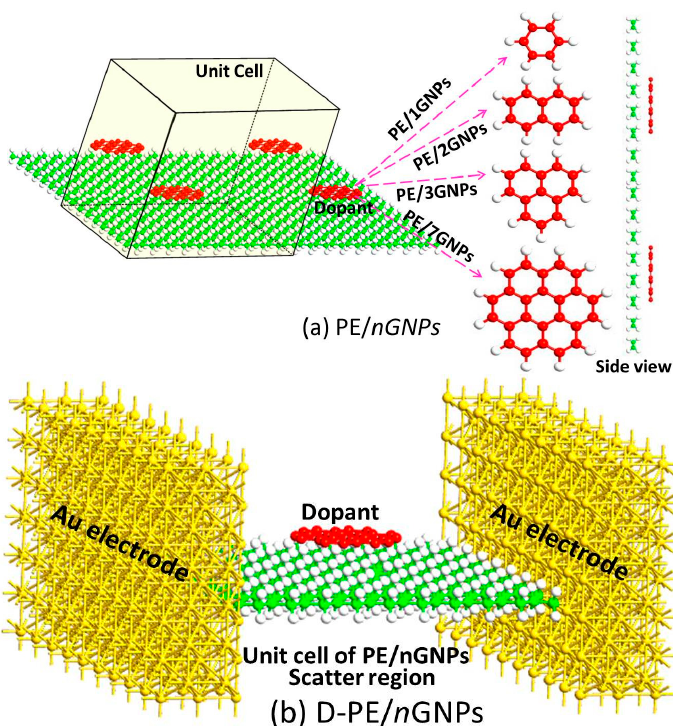
Figure 3. ( a ) Optimized structures of PE/ n GNPs ( n = 1, 2, 3, 7). The unit cell for calculations is also given; ( b ) Two-probe devices of PE/ n GNPs ( n = 1, 2, 3, 7) as one supercell were sandwiched between two Au (100) − (7 × 9) electrodes, five layers were used for the left and right Au electrodes.